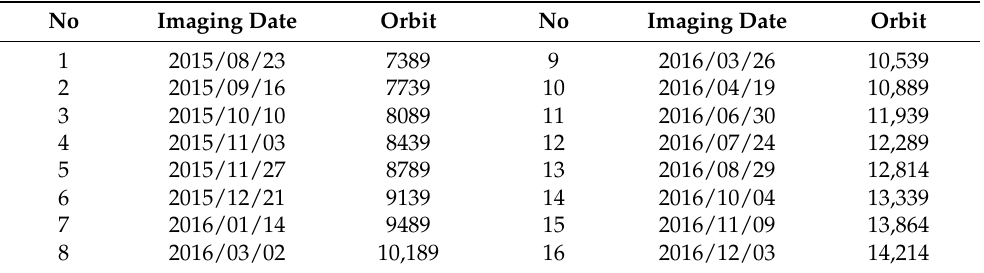
Table 2. The specific parameters of SAR